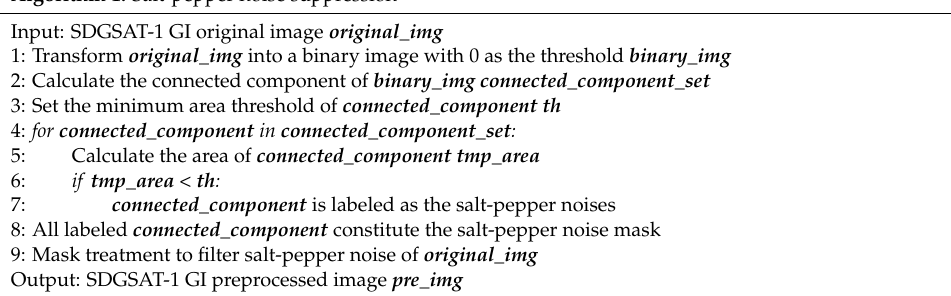
Algorithm 1. Salt-pepper noise